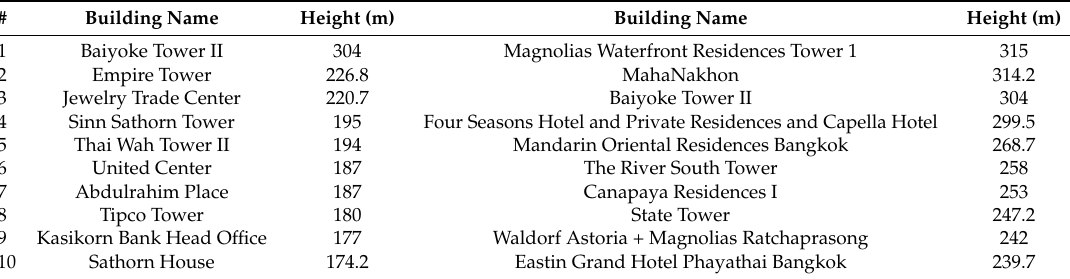
Figure 6. Bangkok in 2000 and 2020. Table 16. Bangkok’s 10 tallest skyscrapers in 2000 and 2020.